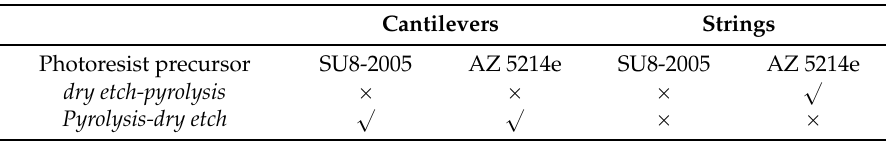
Table 3. Summary of the overall fabrication output for the two different process strategies with the two precursor materials.